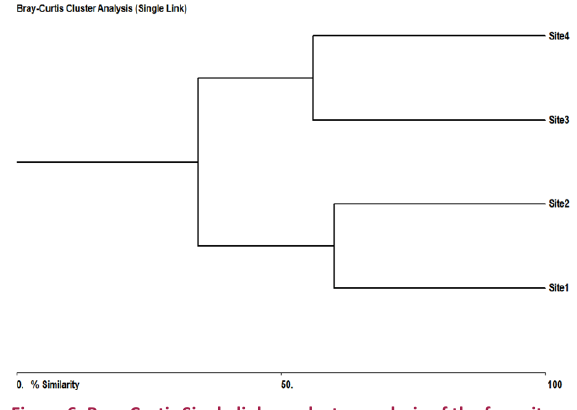
Figure 6. Bray-Curtis Single linkage cluster analysis of the four sites of